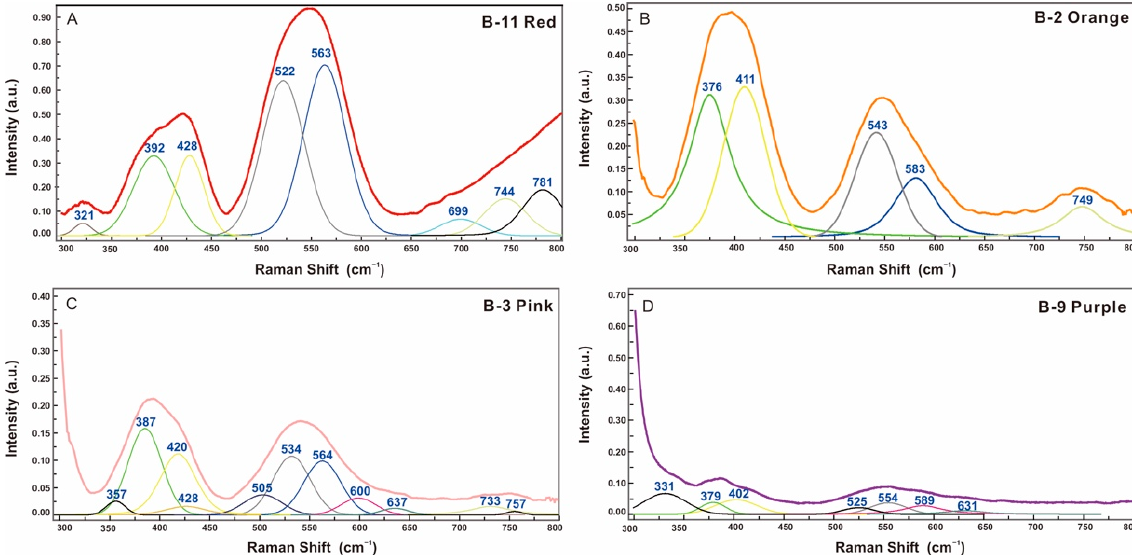
Figure 11. UV–Vis–NIR spectrum and peak-fitting Gaussian curve of Mogok spinel samples of red ( A ), orange ( B ), pink ( C ) and purple ( D ). Red and pink spinel samples are mainly colored by Cr and V elements. The higher the concentration of Cr 3+ and V 3+ , the stronger red tone. The curves obtained by peak fit- ting are shown in Figure11A,C. The electronic transitions of Cr 3+ and V 3+ are the main characteristics of red (B-11) and pink (B-3) samples. The absorption spectra of the samples were fitted with 8 and 11 Gauss curves, respectively. There were two wide absorption broadbands in the range 300–600 nm (Figures 8 and 10A,C). The wide absorption band centered at 400 nm was divided into several parts, which were 392 nm and 428 nm in the red sample. In the pink sample, there are 357 nm, 387 nm, 420 nm and 428nm absorption bands. In the spinel crystal structure, the composition shift is caused by the ionic radius.